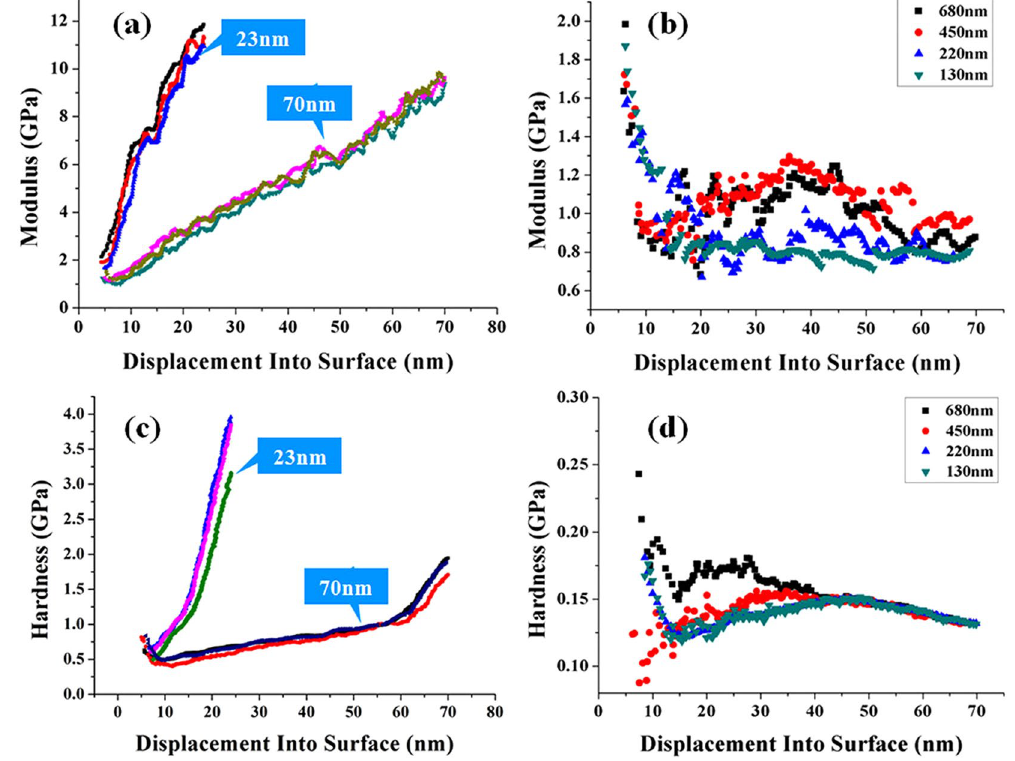
Figure 3. The modulus and hardness curves of 996 kD PMMA at different scales. ( a ) The moduli at 23 nm and 70 nm scales. ( b ) The modulus at 130 nm, 220 nm, 450 nm and 680 nm. ( c ) The hardnesses at 23 nm and 70 nm. ( d ) The hardnesses at 130 nm, 220 nm, 450 nm and 680 nm.